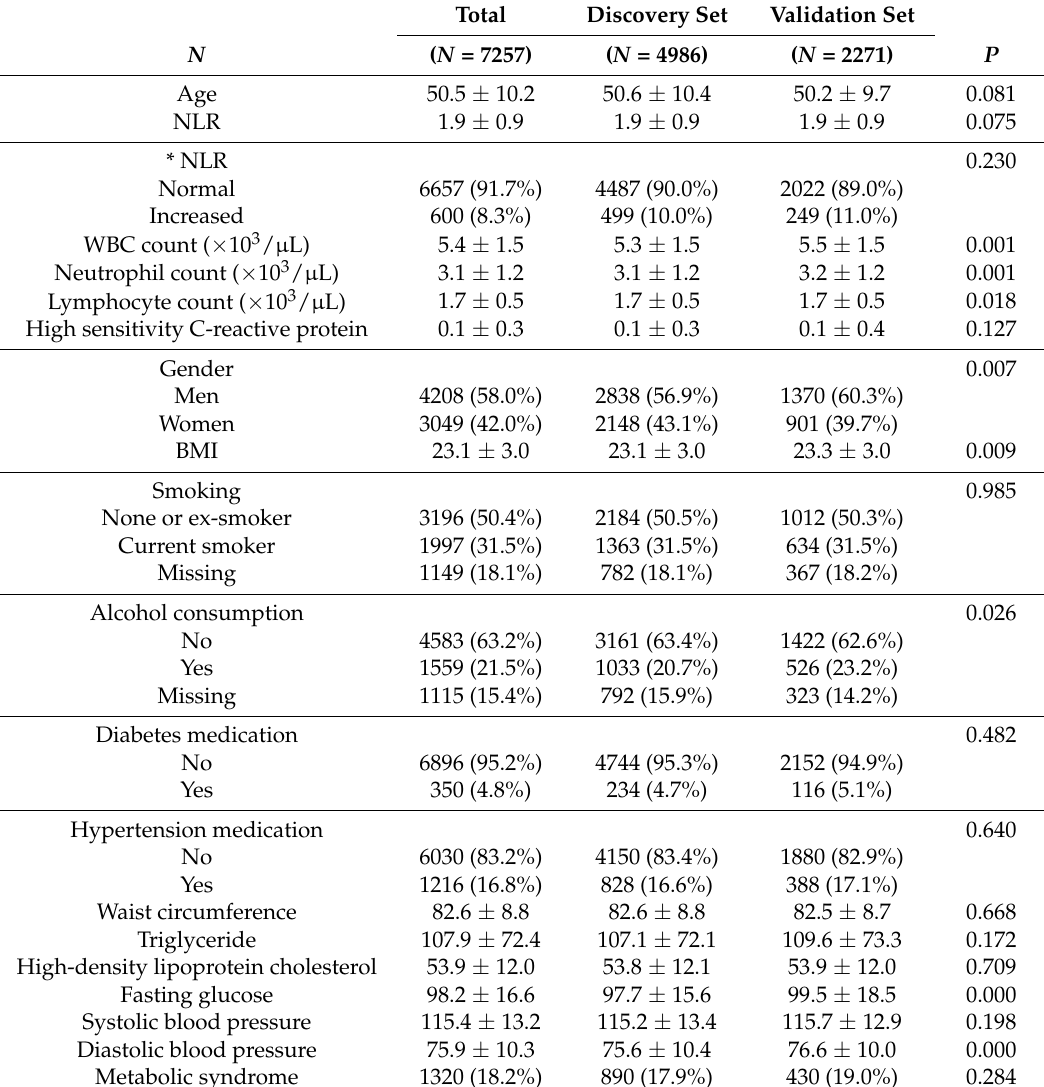
Table 1. Baseline characteristics of the study